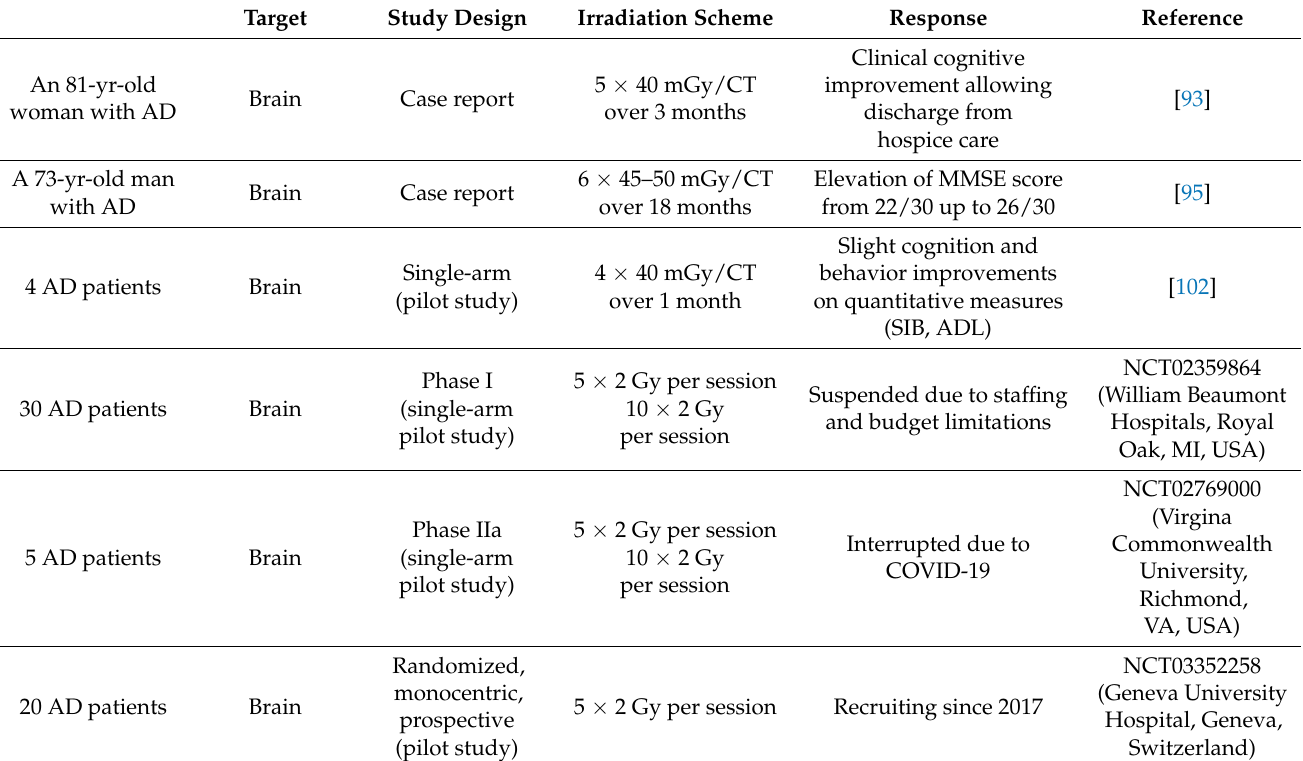
Table 3. State of the art of low-dose radiation therapy (LDRT) in Alzheimer’s disease